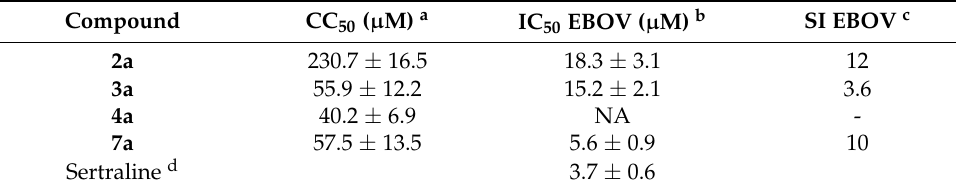
Table 3. Inhibitory activities of derivatives 2a , 3a , 4a , and 7a against